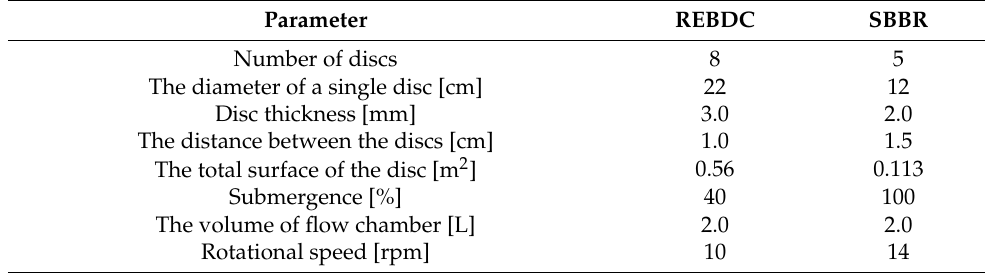
Table 1. Technical parameters of reactors.